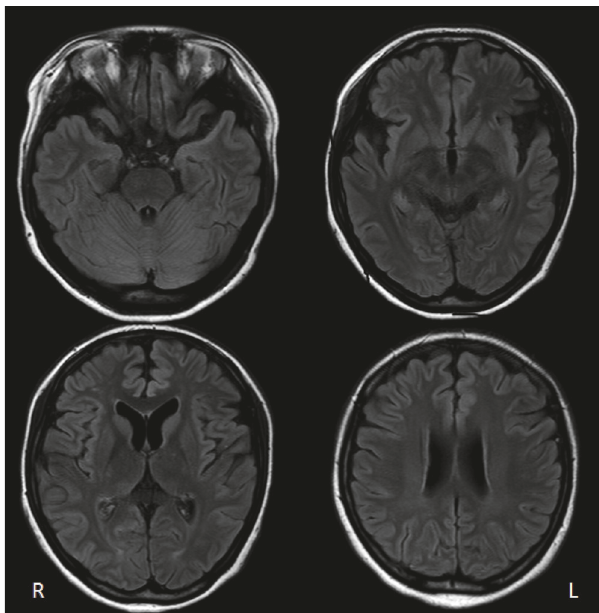
Figure 1: Axial fluid-attenuatedinversion recovery (FLAIR) images of the brain two months after admission. Note the slight high intensities in the bilateral occipital cortices and subcortical white matter,which were somewhatprominent on the right side, as well as small subcortical high intensities in the right frontal lobe. However, there were no signal abnormalities in the medial temporal areas.